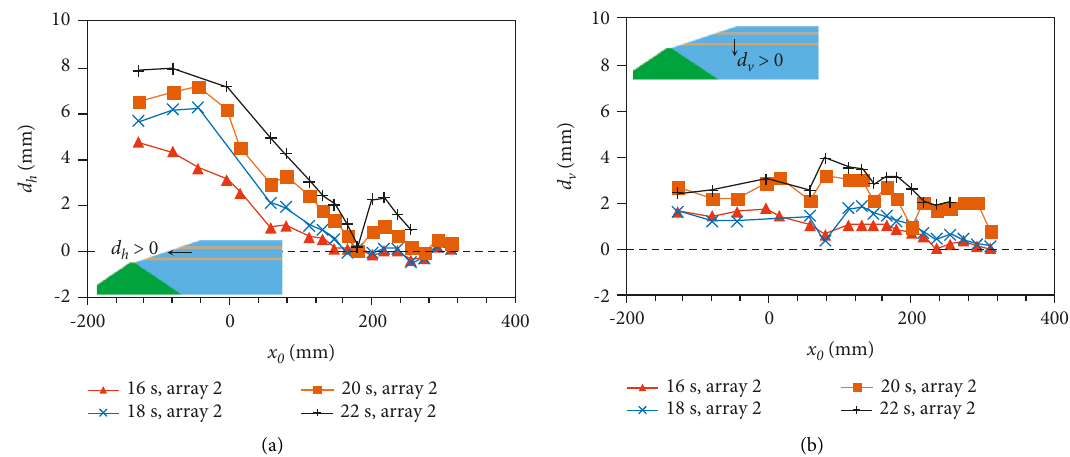
Figure 14: Horizontal distributions of (a) horizontal and (b) vertical displacements of the trace markers in array 2 below the relative shallow silty layer in stage 3.